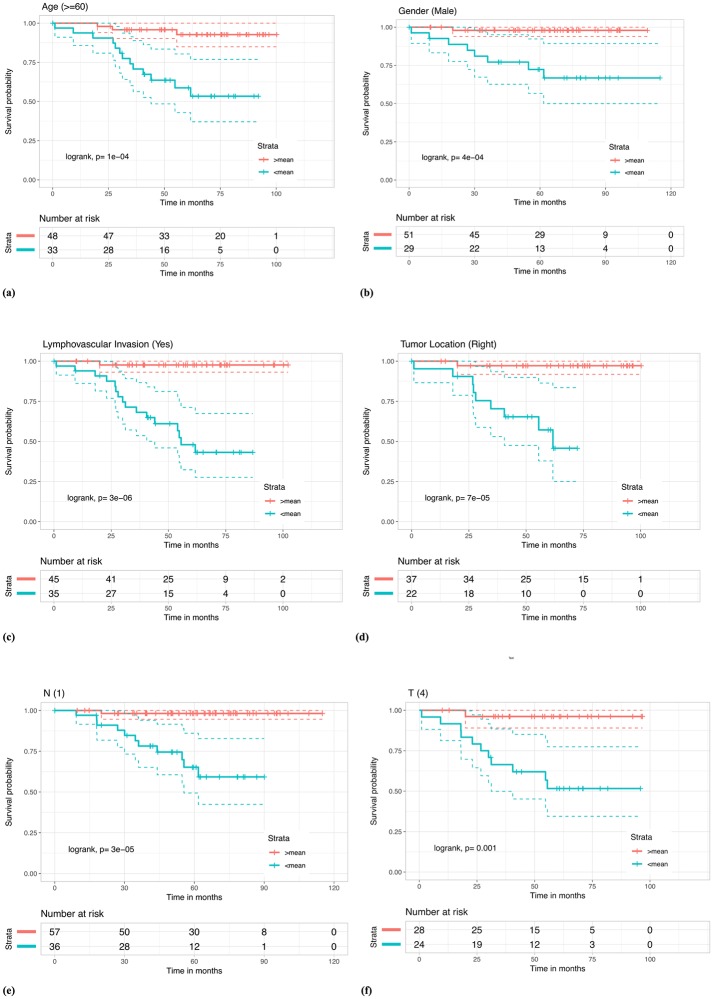
Kaplan Meier survival curves for risk estimation in the sub-populations of CRC stage III patient cohort based on RS using the mean (RS = 0) cutoff, show significant differences in high/low risk groups.(a) Samples with patient age greater than 60y were stratified (log rank, p = 1e-04) in high/low risk groups with HR = 8.03 and p-value = 0.0017. (b) Male patients were stratified (log rank, p = 4e-04) within high/low risk groups with HR = 15.91 and p-value = 0.0091. (c) Patient with lymphovascular invasion were stratified (log rank, p = 3e-06) in high/low risk groups with HR = 24.92 and p-value = 0.0018. (d) Patients with tumor location in the right side were stratified (log rank, p = 7e-05) in high/low risk groups with HR = 20.16 and p-value = 0.0046. (e) Patient samples with N-stage 1 were stratified (log rank, p = 3e-05) in high/low risk groups with HR = 21.11 and p-value = 0.0046. (f) Patients in T stage 4 were stratified (log rank, p = 0.001) in high/low risk groups with HR = 13.65 and p-value = 0.0124.